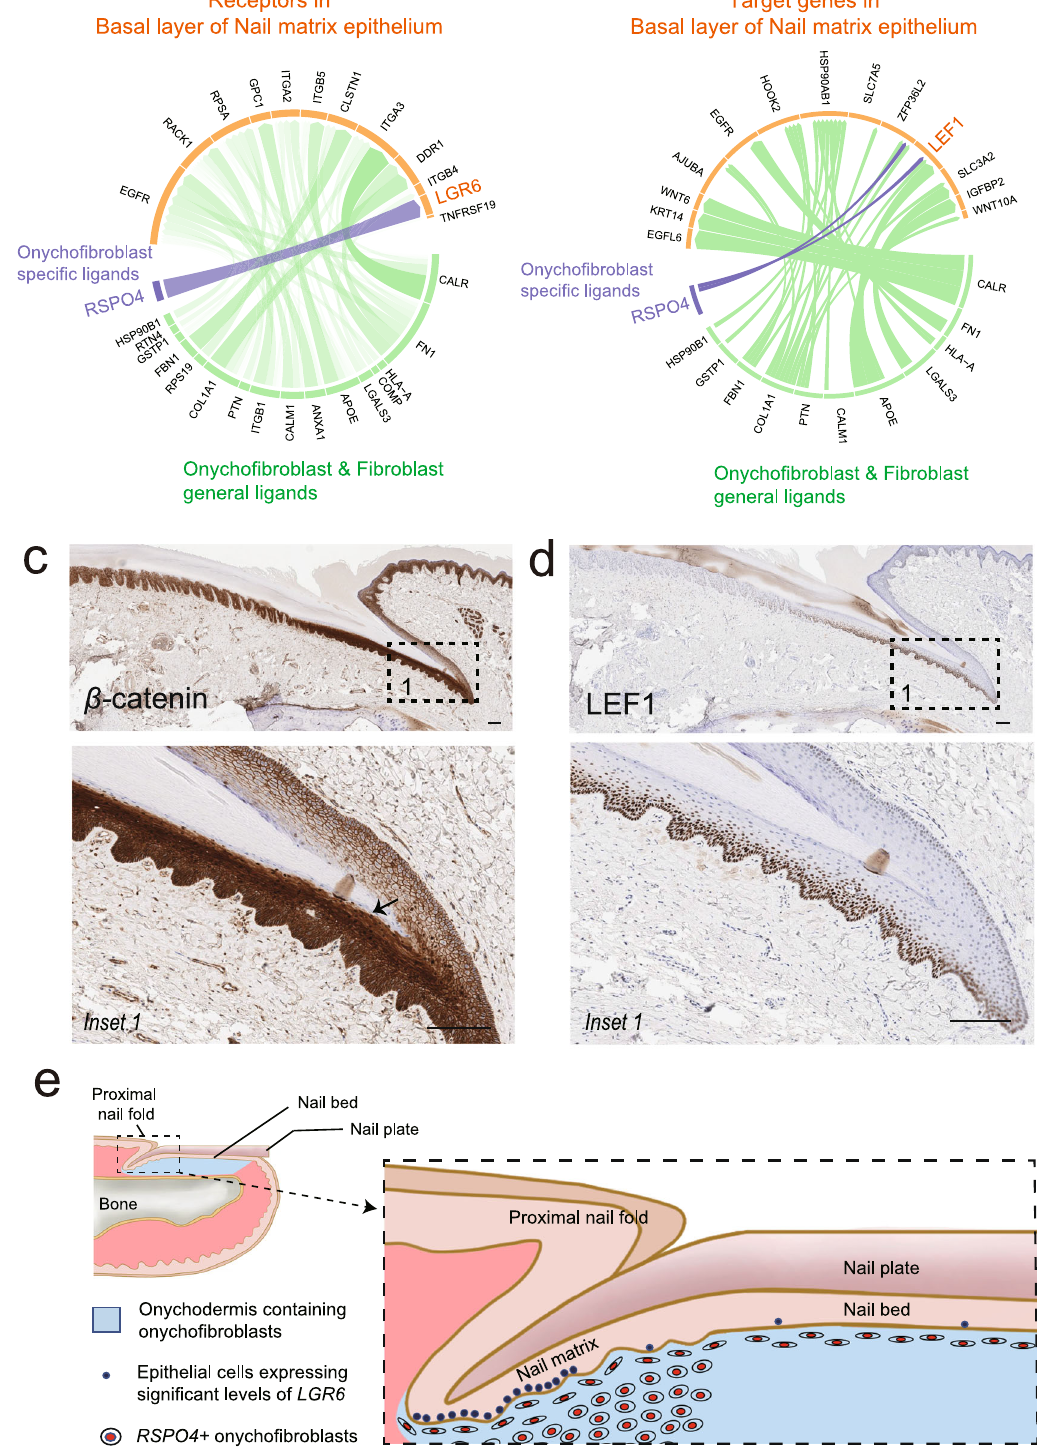
opment through WNT